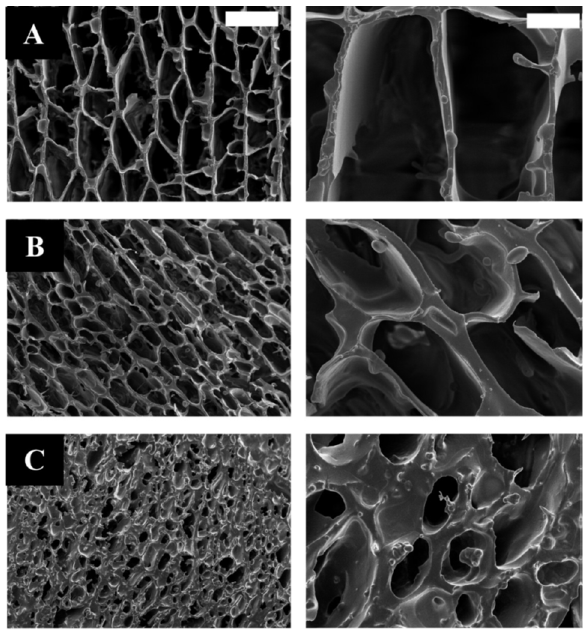
Figure 19. Schematics of a cell culture spreading on the surface of a sol-gel scaffold for tissue engineering applications.